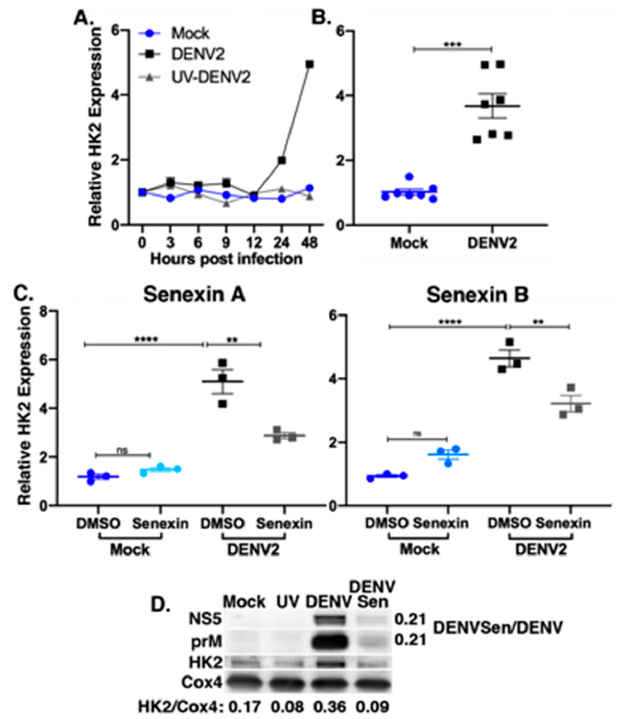
Figure 4. Senexin A reduces DENV2 induction of Hexokinase 2 expression. ( A ) Huh7 cells were either mock-infected or infected with DENV at MOI 10, and HK2 mRNA expression analyzed by qRT-PCR at indicated time points. Results are representative of two independent experiments. Expression is relative to time of infection and normalized to SDHA . ( B ) HK2 expression in mock vs. infected cells at 48 hpi ( n = 7 biological replicates; *** p < 0.001 unpaired, two-tailed t test with Welch’s correction). Error bars represent mean +/ − SEM. ( C ) HK2 mRNA expression in mock-infected and infected Huh7 cells treated with DMSO or 25 µ M Senexin A or 12 µ M Senexin B added at start of infection (MOI 10; 36 hpi). Expression relative to mock-infected, DMSO-treated cells and normalized to SDHA ( n = 3 biological replicates; ** p < 0.01, **** p < 0.0001; one-way ANOVA with Tukey’s multiple comparisons test). Error bars represent mean +/ − SEM. ( D ) Western blot analysis of cellular and viral protein abundance in 2 µ g mitochondrial-enriched fractions from mock-infected cells (Mock), or cells with 10 MOI UV-treated DENV2 (UV) or DENV2 without (DENV) or with or 25 µ M Senexin A (DENV / Sen). Antibody specificities are indicated as are the relative band densities of HK2 versus Cox4. Relative band densities of DENV2 NS5 and prM proteins in Senexin A-treated versus DMSO-treated, DENV2-infected cell preparations are indicated to the right of the indicated panels. Results are representative of six biological